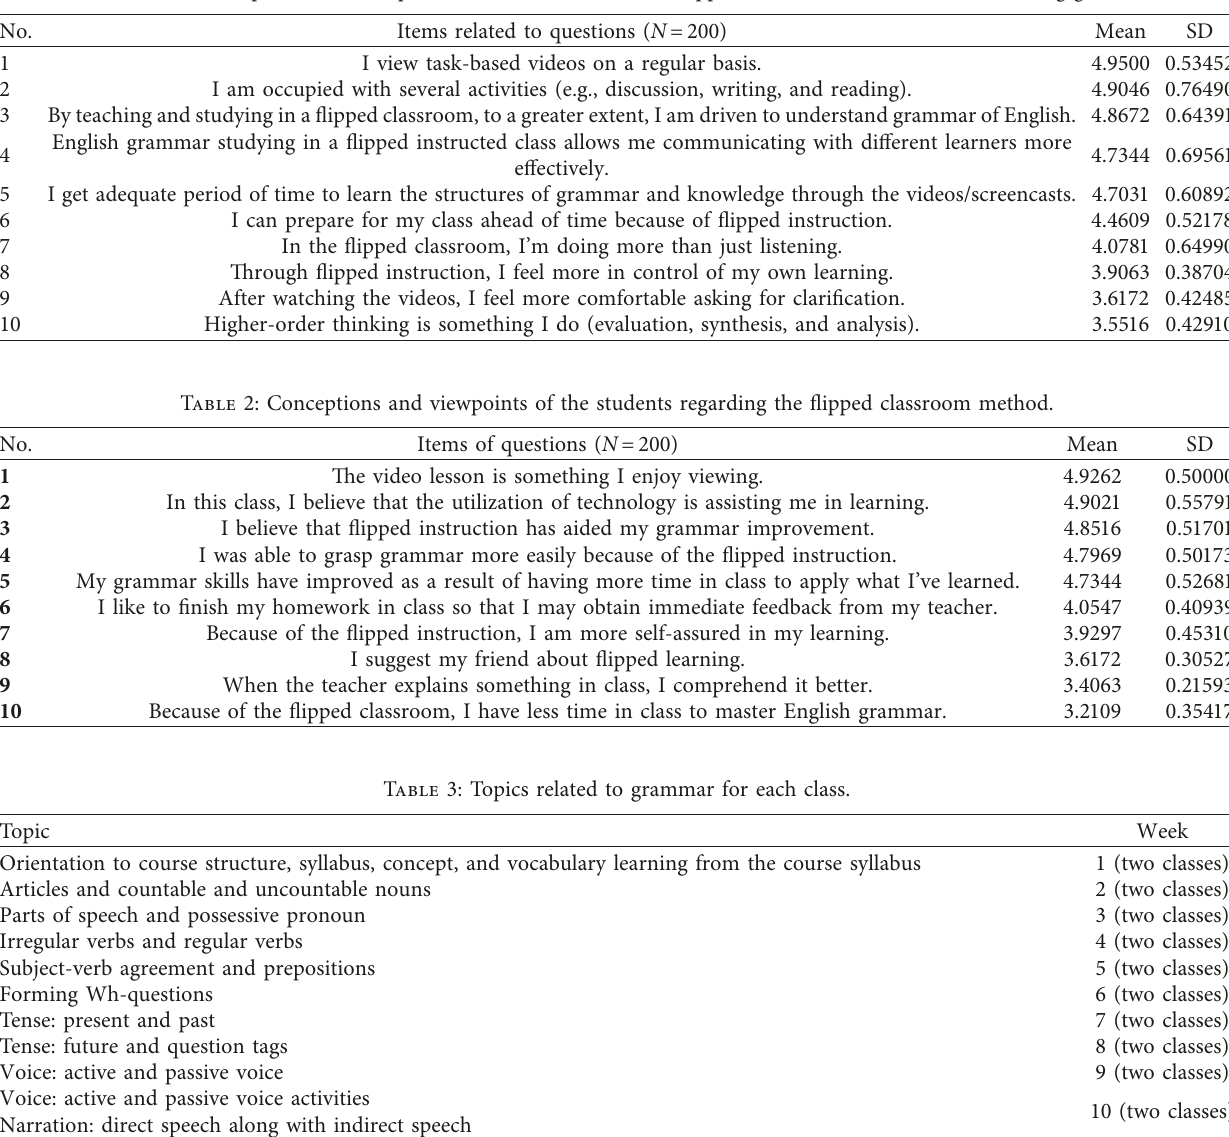
Table 1: The conceptions and viewpoints of the students toward flipped instructed class lessons of learning grammar.